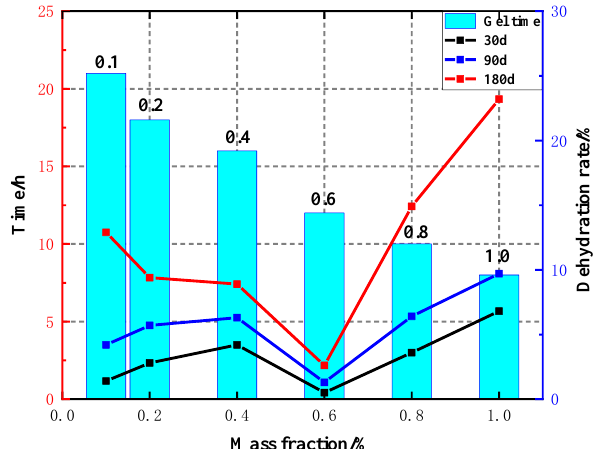
Figure 6. Effect of the crosslinking agent mass fraction on the stability of the frozen gel. Note that the left y-axis values in Figure 6 is used for histograms, and the right y-axis values are used for the line charts; 30 d/90 d/180 d represent 30 days, 90 days, 180 days of dehydration, respectively.